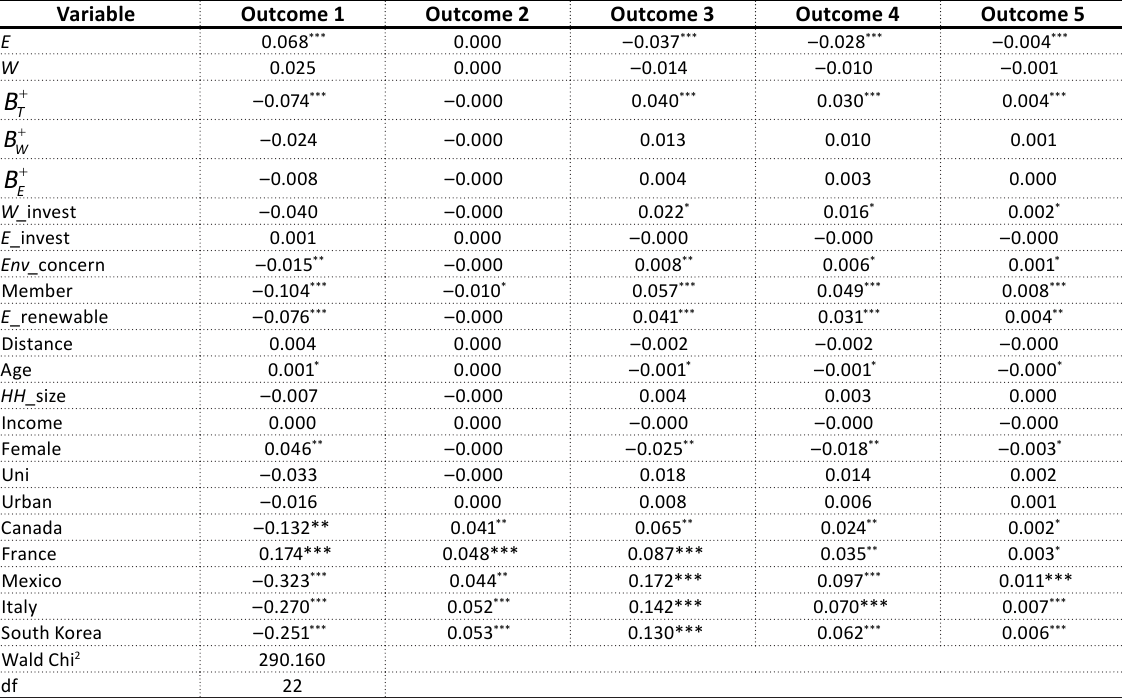
Table B4. Average discrete effects of ordered probit, dependent variable: ordinal responses for